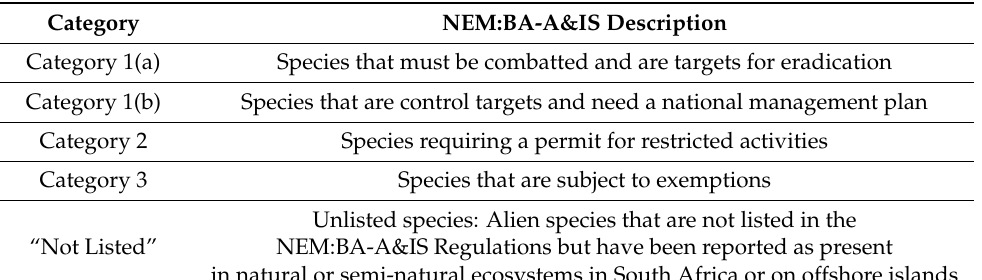
Table 2. Different categories of alien and invasive species following the NEM:BA-A&IS Regulations,